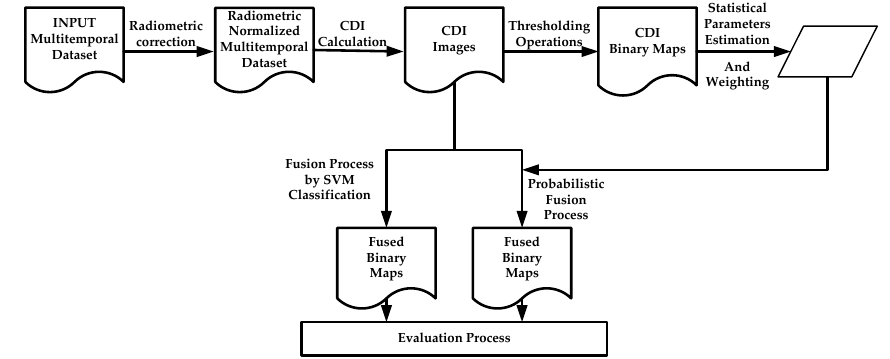
Figure 1. Global change detection suggested methodology.